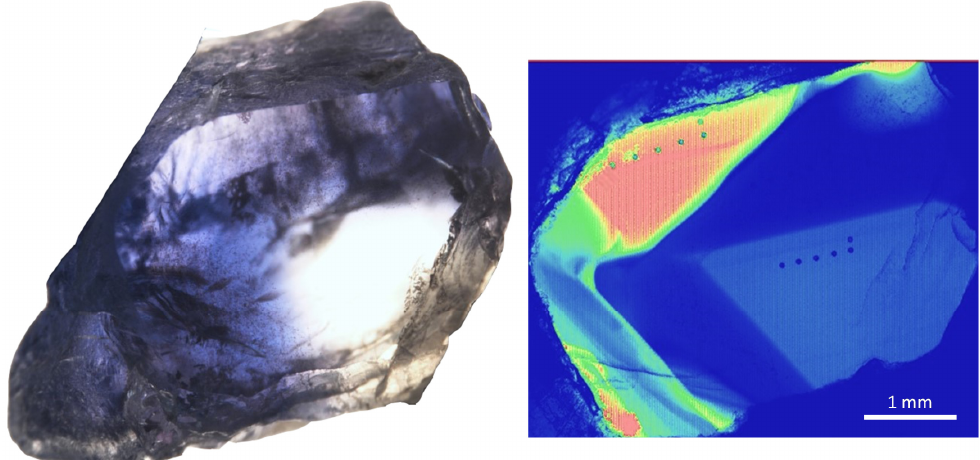
Figure 16. Photo of a Burmese blue sapphire wafer showing diffuse color zoning (left). On the right is the Cr distribution map of the same sapphire created by PL mapping. Using color zoning to provide information on geographic origin is essentially using information about the spatial distribution of trace elements, specifically Fe and Ti in the case of sapphires. Hypothetically, having the ability to map out distributions of any trace elements in corundum may also provide additional information that could provide a unique fingerprint leading back to a stone’s geographic origin. Trace element mapping with laser ablation–inductively coupled plasma–mass spectrometry (LA-ICP-MS) has been performed on gem corundum before (e.g., [45]), but the LA-ICP-MS mapping method is time-intensive and destructive. Another option is to use PL mapping to look for variations in the intensity of the Cr 3+ luminescence peaks centered at 692.9 and 694.3 nm (see, for example, Figure 12C) in order to map out variation in chromium (Cr) concen- trations within a single crystal. PL mapping has been used before to delineate the crystal growth history of rubies and blue sapphires from Yogo Gulch, Montana [15,46]. Of par- ticular note is that the distribution of Cr in Yogo sapphires can reveal complicated growth patterns that would not be visible in these sapphires that otherwise show homogeneous distribution of color and other trace elements. For whatever reason, Cr often seems to be- come incorporated very differently in corundum than the other trace elements (e.g., [47]). PL maps were produced for the sharply blue-zoned Madagascar sapphire in Figure 15 and the diffuse-zoned Burmese sapphire in Figure 16. In both cases, the Cr-distribution identified by PL mapping correlates well with the observed color zoning. In some cases, however, PL mapping can shed light on crystal growth patterns that do not show up through observation of color zoning (Figure 17).